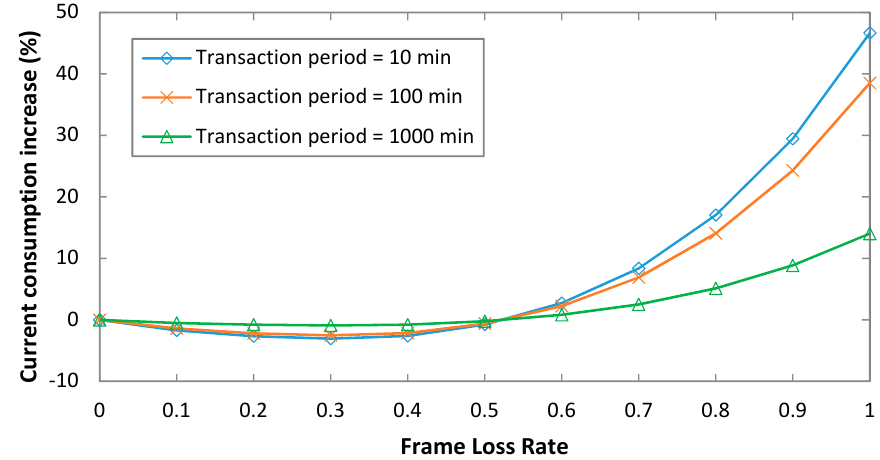
Figure 8. Impact of FLR on the average current consumption of the device, for bidirectional transactions, for an uplink bit rate of 100 bit/s, for an uplink payload size of 1 byte, and for different values of T Period .